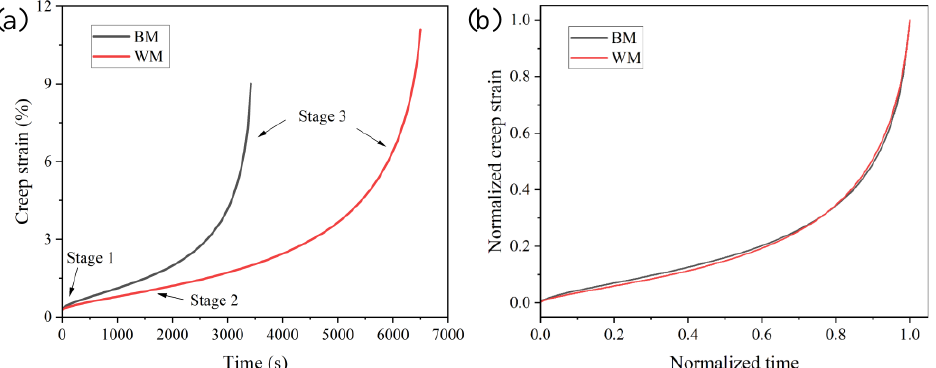
Figure 7. ( a ) Creep deformation curves of 2.25Cr1Mo0.25V steel BM and WM at 550 °C. ( b ) Normalized creep curves using the corresponding lifetime and creep strain.